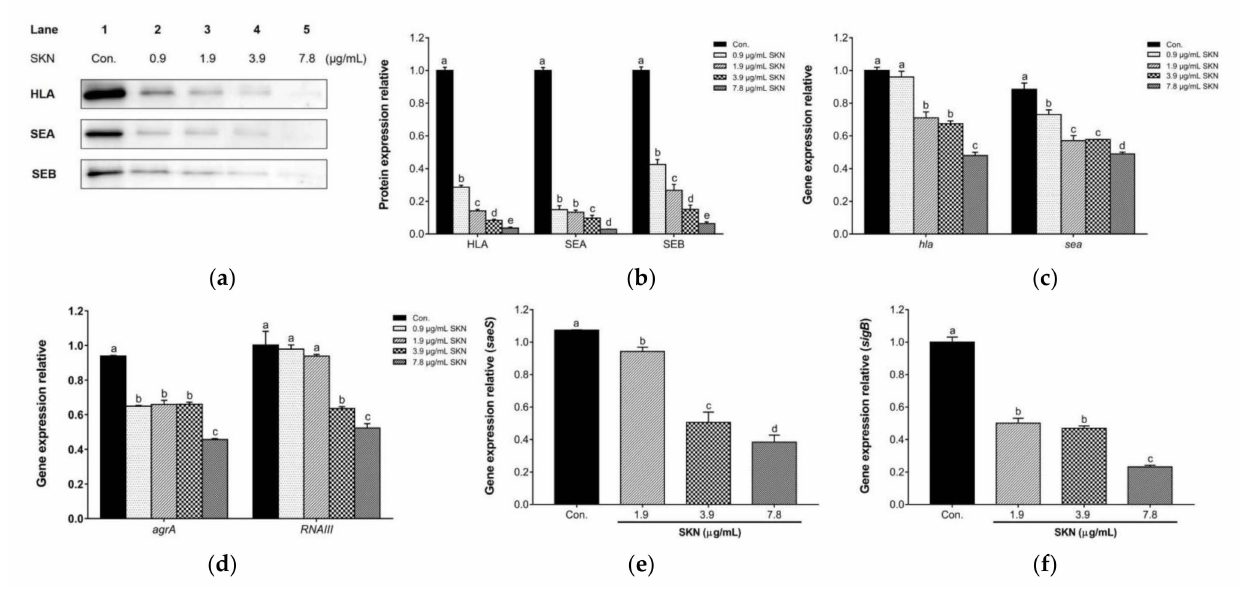
Figure 7. ( a ) The effect of SKN on the protein expression of α -hemolysin (HLA), staphylococcal enterotoxin A (SEA) and staphylococcal enterotoxin B (SEB) in clinical MRSA strain DPS-1, as analyzed by Western blot. ( b ) The intensities of Western blot protein bands were quantified using ImageJ software. ( c ) The effect of SKN on the mRNA expression of genes encoding HLA (hla) and SEA (sea), as analyzed by qRT-PCR. The effect of SKN on the mRNA expression of regulatory genes agrA ( d ), RNAIII ( d ), saeS ( e ), and sigB ( f ) in clinical MRSA strain DPS-1. The data are means ± SD of triplicate determinations. Different letters on the bars indicate significant statistical differences between treatments ( p < 0.05), while the same letters mean no significant differences ( p > 0.05).